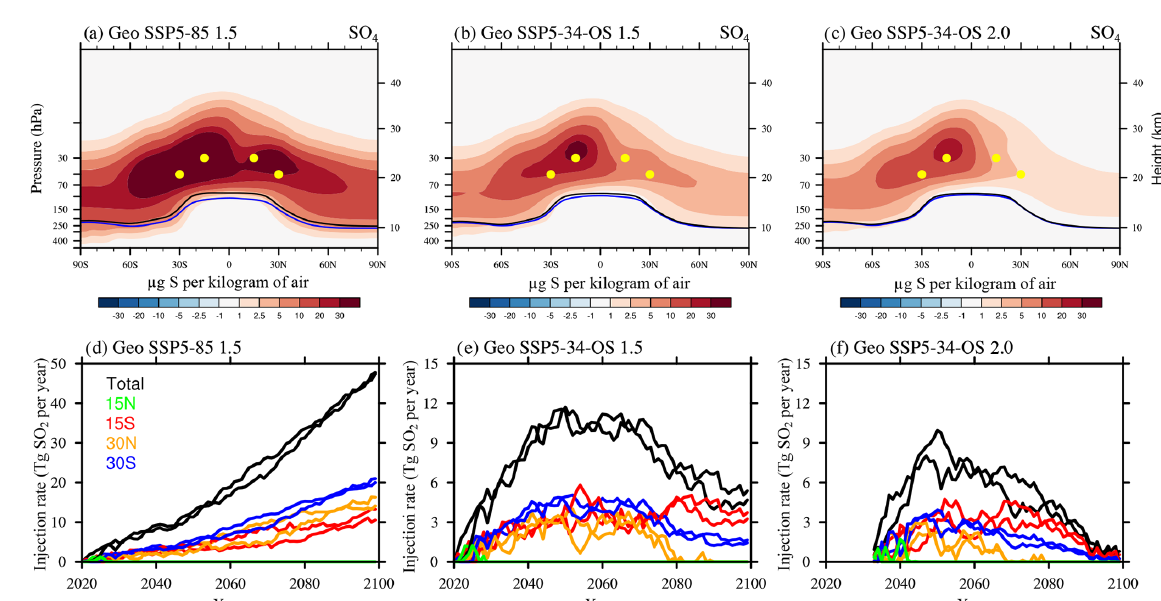
Figure 2. (a–c) Difference of zonally and annually averaged sulfate SO 4 burden between the ensemble average of stratospheric sulfur injection cases in 2070–2089 and the control experiment for the same period for Geo SSP5-85 (a) , Geo SSP5-34-OS 1.5 (b) , and Geo SSP5- 35-OS 2.0 (c) . The lapse rate tropopause is indicated as a black line for the control and a blue line for the SO 2 injection cases. Yellow dots indicate locations of injection. (d–f) Injection rate in TgSO 2 per year for the three cases as in panels (a–c) (including two ensemble members): total injections (black), injections at 15 ◦ N (green), 15 ◦ S (red), 30 ◦ N (orange), and 30 ◦ S